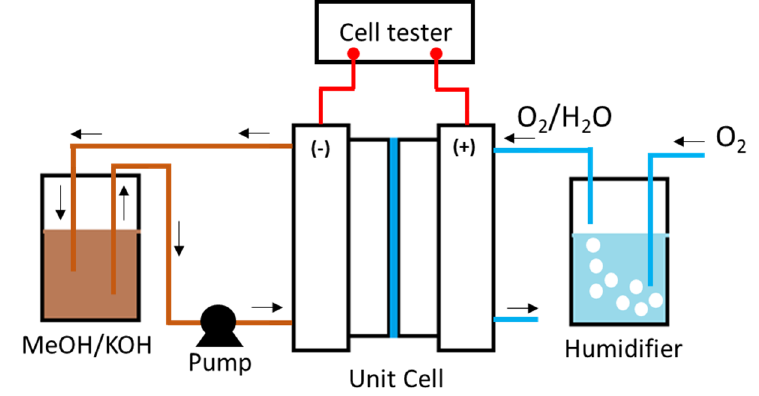
Figure 1. Schematic diagram of the test setup of an alkaline alcohol fuel cell.